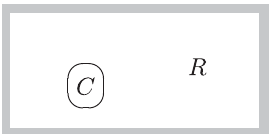
FIG. 1. Sample system for the Boltzmann factor instructional sequence. An isolated container of an ideal gas is separated into a small system ( C ) and a large reservoir ( R ). The label “ C ” is used to avoid confusion with